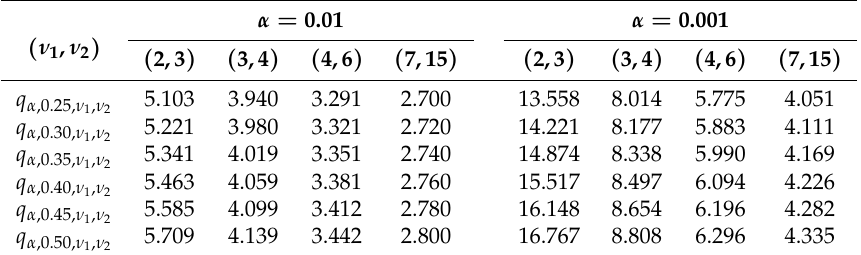
Table A2. Accurate numerical values of q for different α , β 1 , β 2 (= 1 − β 1 ) , ν 1 , and ν 2 in α , { β i } 2 i = 1 , { ν i } 2 i = 1 the case of multivariate Student t mixture. The table reproduces numerical values of q for α , { β i } 2 i = 1 , { ν i } 2 i = 1 different α , β 1 , β 2 (= 1 − β 1 ) , ν 1 , and ν 2 of interest as tabulated in [7] (Tables 1 and 2) and [8] (Tables 2 and 3) for the purposes of computing expected